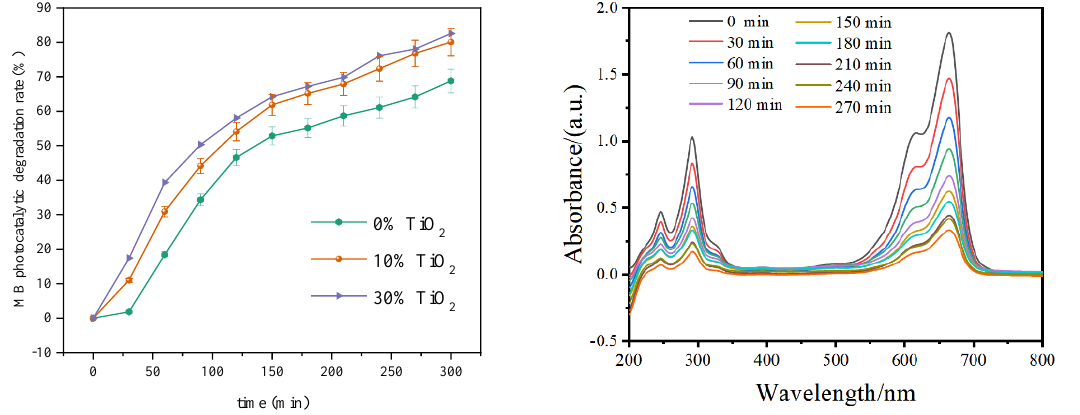
Figure 10. Photocatalytic degradation/removal of MB by the electrospun xylan-g-PMMA/TiO 2 fibers (a: 0% TiO 2 ; b: 10% TiO 2 ; c: 30% TiO 2 ). The left figure is the UV-vis spectra for the MB solution alone and in the presence of the catalyst during the entire photodegradation process, corresponding to the trends.